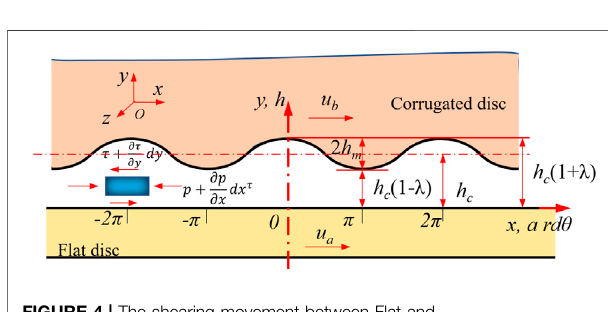
FIGURE 4 | The shearing movement between Flat and Corrugated